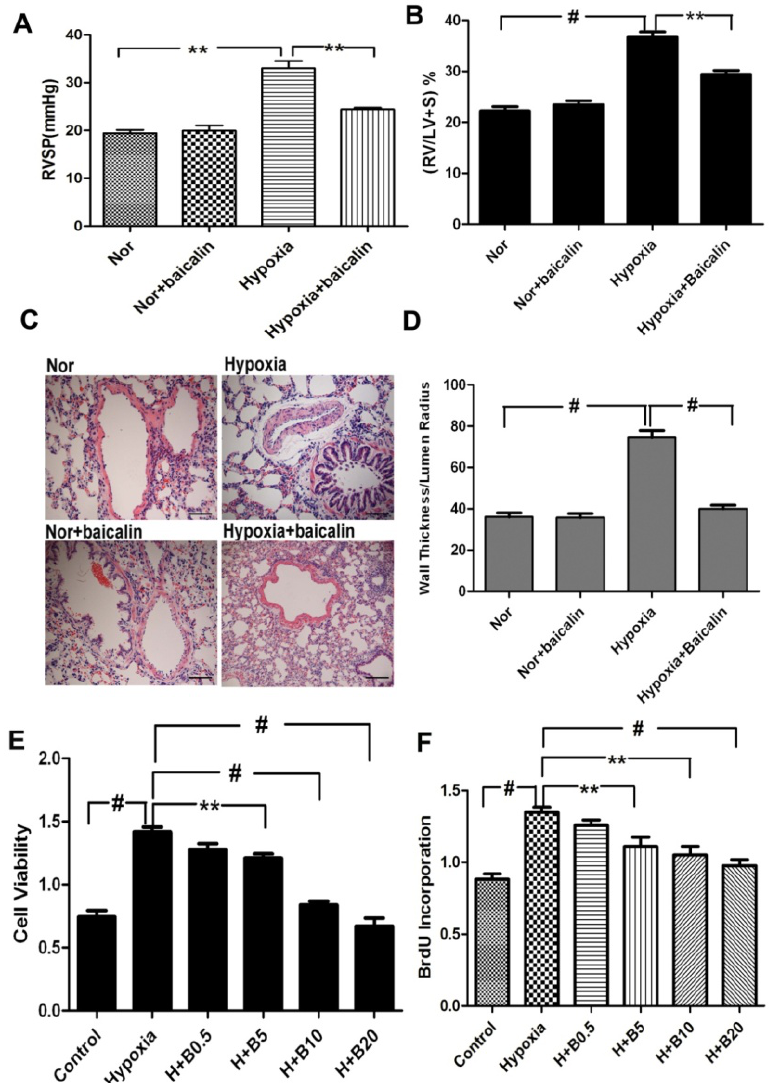
Figure 1. Baicalin attenuates chronic hypoxia-induced pulmonary hypertension and pulmonary vascular remodeling and inhibits rat pulmonary artery smooth muscle cell (PASMC) proliferation under hypoxia exposure. ( A ) Changes in right ventricular systolic pressure (RVSP); ( B ) Changes in the right ventricle/left ventricle plus septum (RV/LV + S) ratio; ( C ) Hematoxylin and eosin staining of pulmonary arterioles (original magnification ×20); ( D ) The ratio of intimal-to-medial areas of the vessel; ( E ) Hypoxia led to a significant increase in cell viability compared with the normoxic condition, while baicalin inhibited the effect in a concentration-dependent manner; ( F ) Hypoxia exposure significantly increased the cell proliferation. However, the hypoxia-induced proliferation of PASMCs was obviously inhibited by various dosages of the baicalin treatment. “Nor” means normoxia; “H” means hypoxia; “B” means baicalin. ( # p < 0.001; ** p < 0.01). All values are denoted as the mean ± SEM from six separate